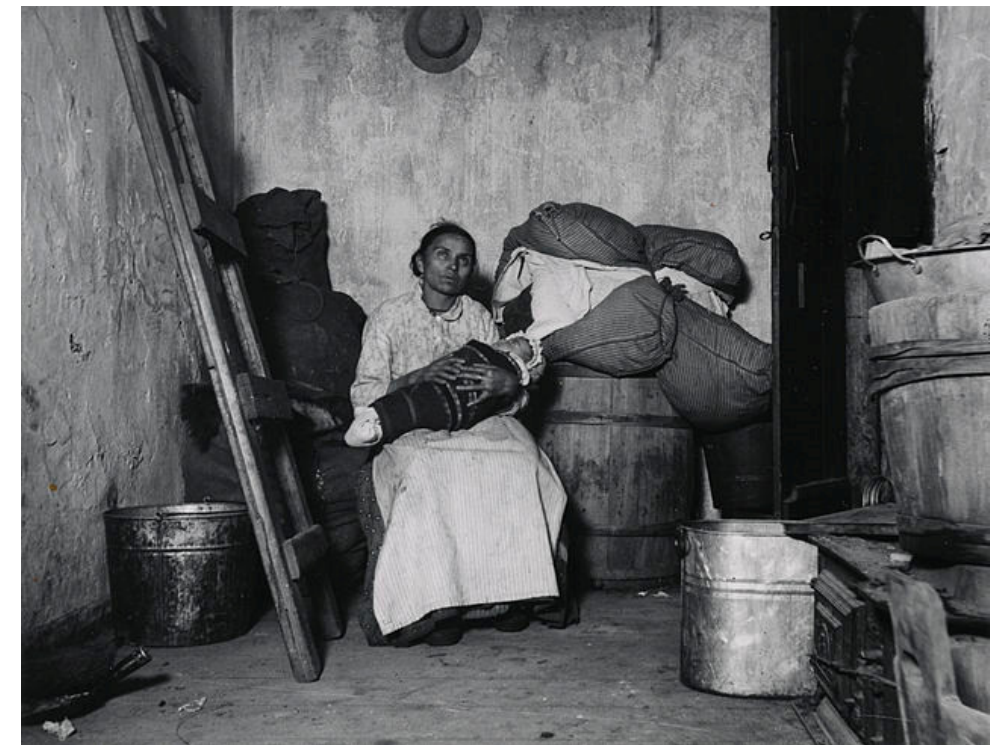
Figure 17. Jacob Riis, Italian Rag Picker in Her Home. Wikicommons.